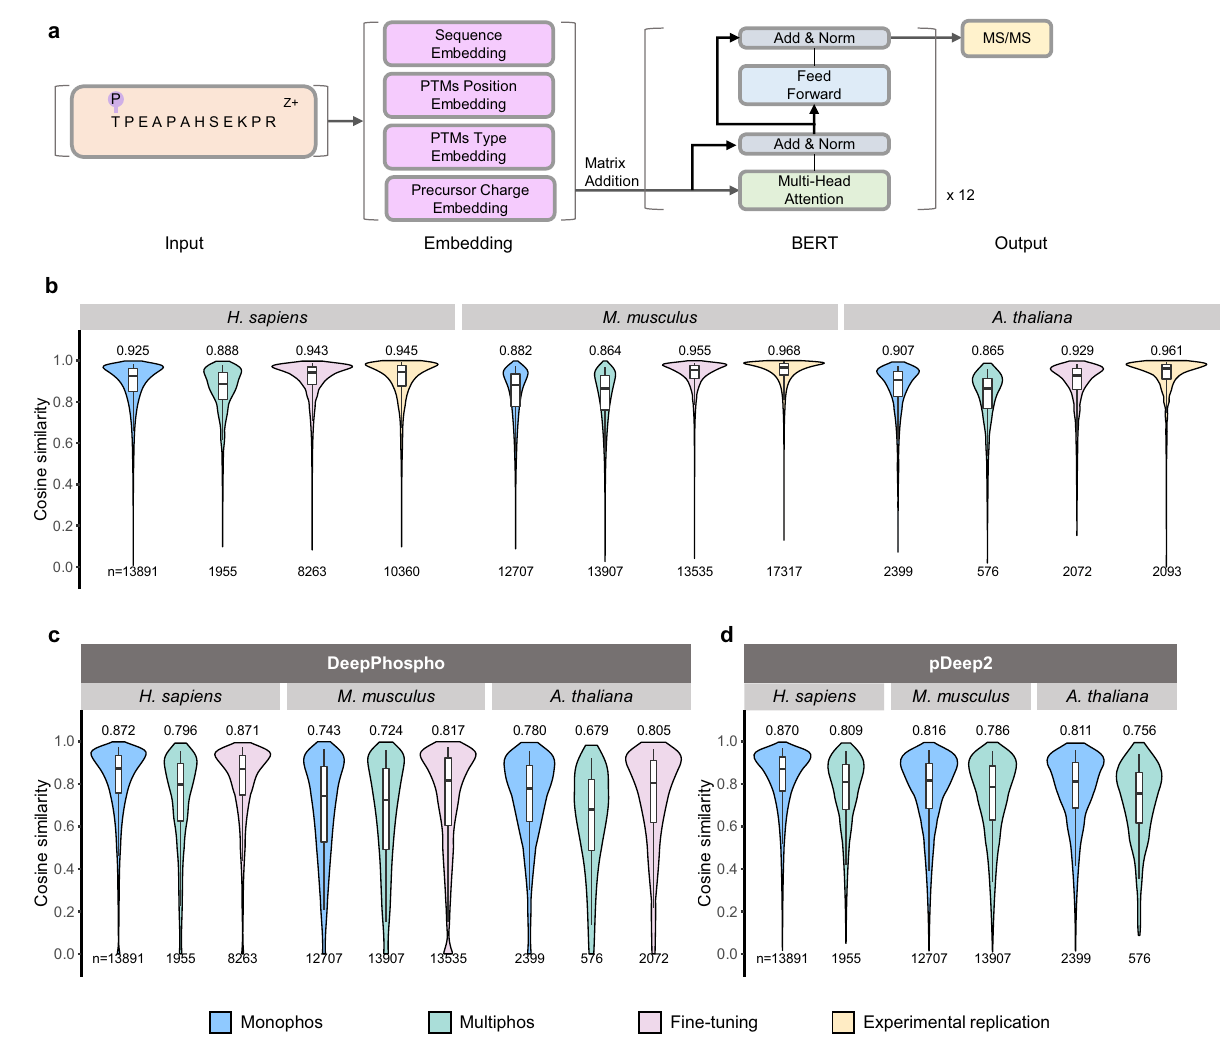
Fig. 1 |Modelarchitectureand performancecomparison. a The DeepFLRmodel architecture: input, the embedding layer,BERT encoder, and the output layer. The distribution of cosine similarity computed between the predicted and experi- mentalspectrafor b DeepFLR, c DeepPhospho,and d pDeep2.Thecosinesimilarity of repeatedly collected mass spectra in the same dataset of the same